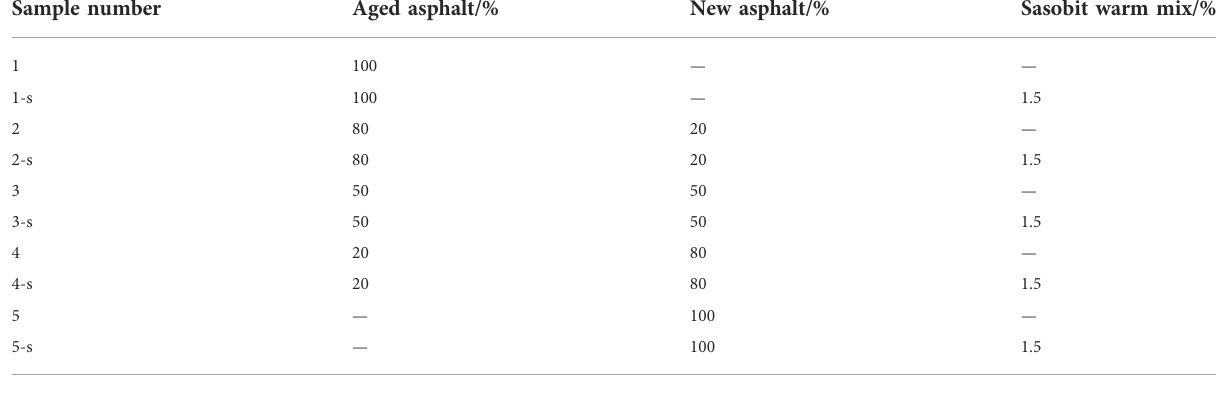
TABLE 3 Mixing proportion and nomenclature for each investigated asphalt.